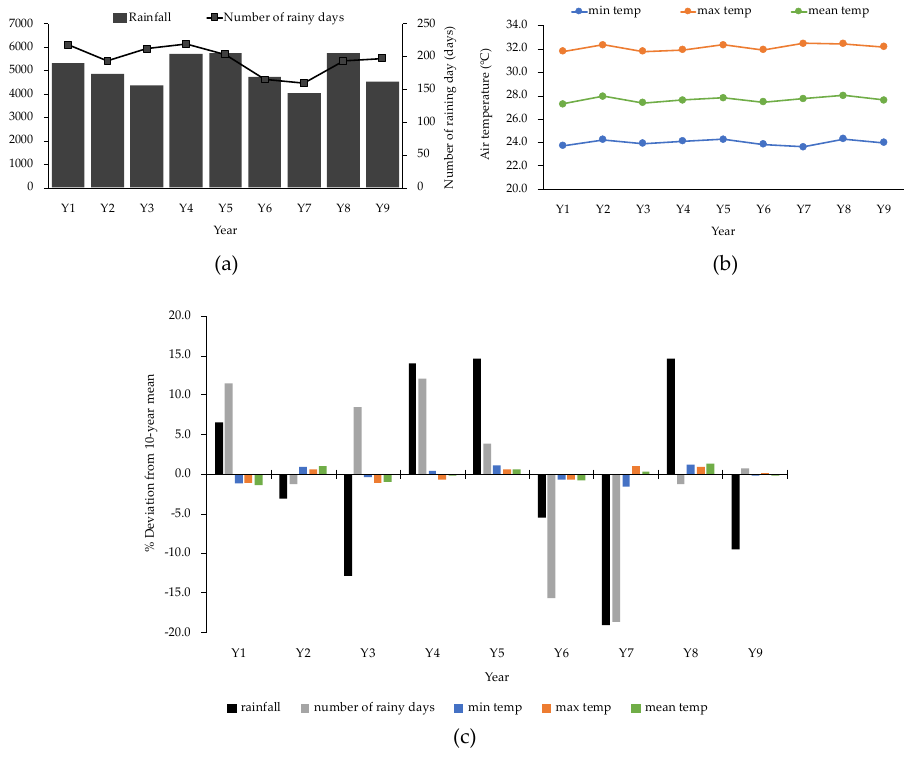
Figure 5. Climatic data at the Klong Yai Weather Station in Trat Province from Y1 to Y9; ( a ) annual rainfall and number of rainy days; ( b ) average minimum, maximum, and mean air temperature; and ( c ) percent deviation of the climatic data from the mean values from Y1 to Y9.